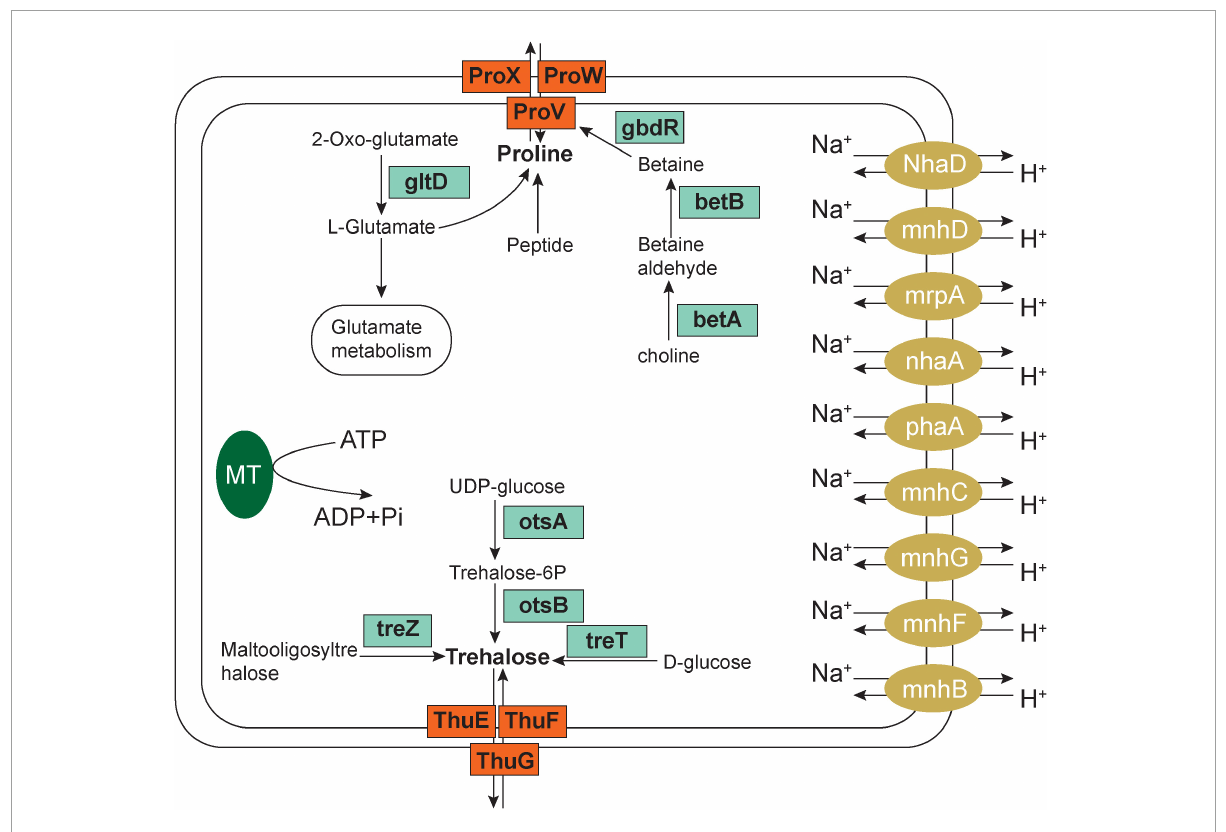
FIGURE6 Salt tolerance-related pathways and mechanisms of salt lake